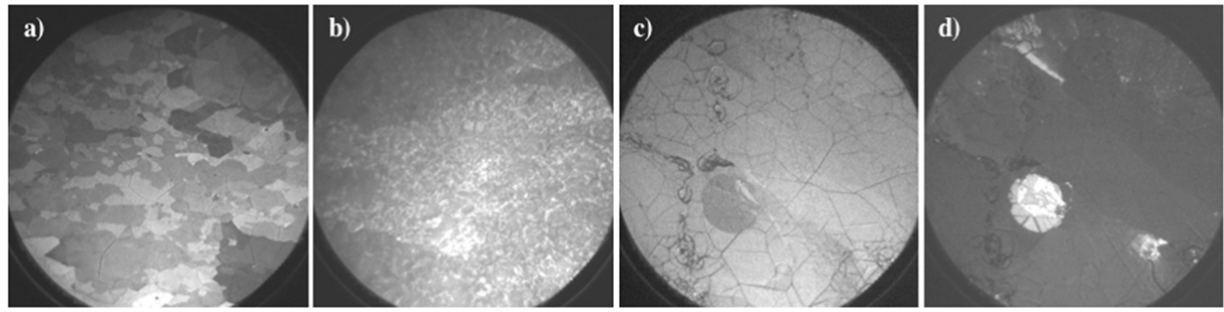
Figure 5. LEEM image collected at 1.7 eV and a FOV of 50 μ m, from a C-face sample ( a ) as-grown and ( b ) after hydrogen treatment. The images in ( c ) and ( d ) were collected at a FOV of 25 μ m from another hydrogen treated sample at an energy of 1.7 eV and 6.5 eV, respectively. The circular dark and bright spot observed in ( c ) and ( d ) was created by electron beam illumination during collection of μ -LEED